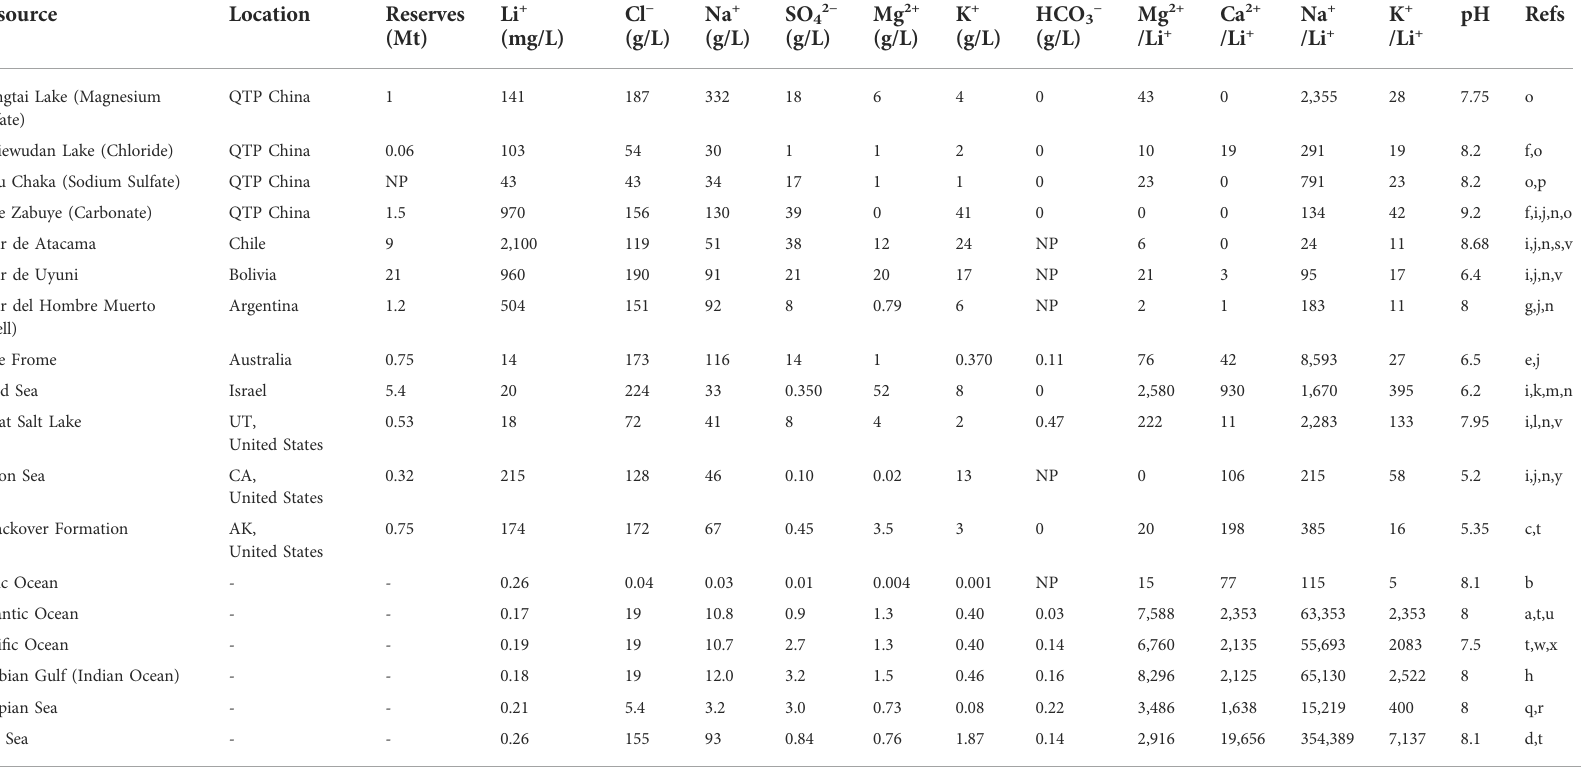
TABLE 1 Major ionic concentration and competing ion mass ratios of select salt lakes and oceans.